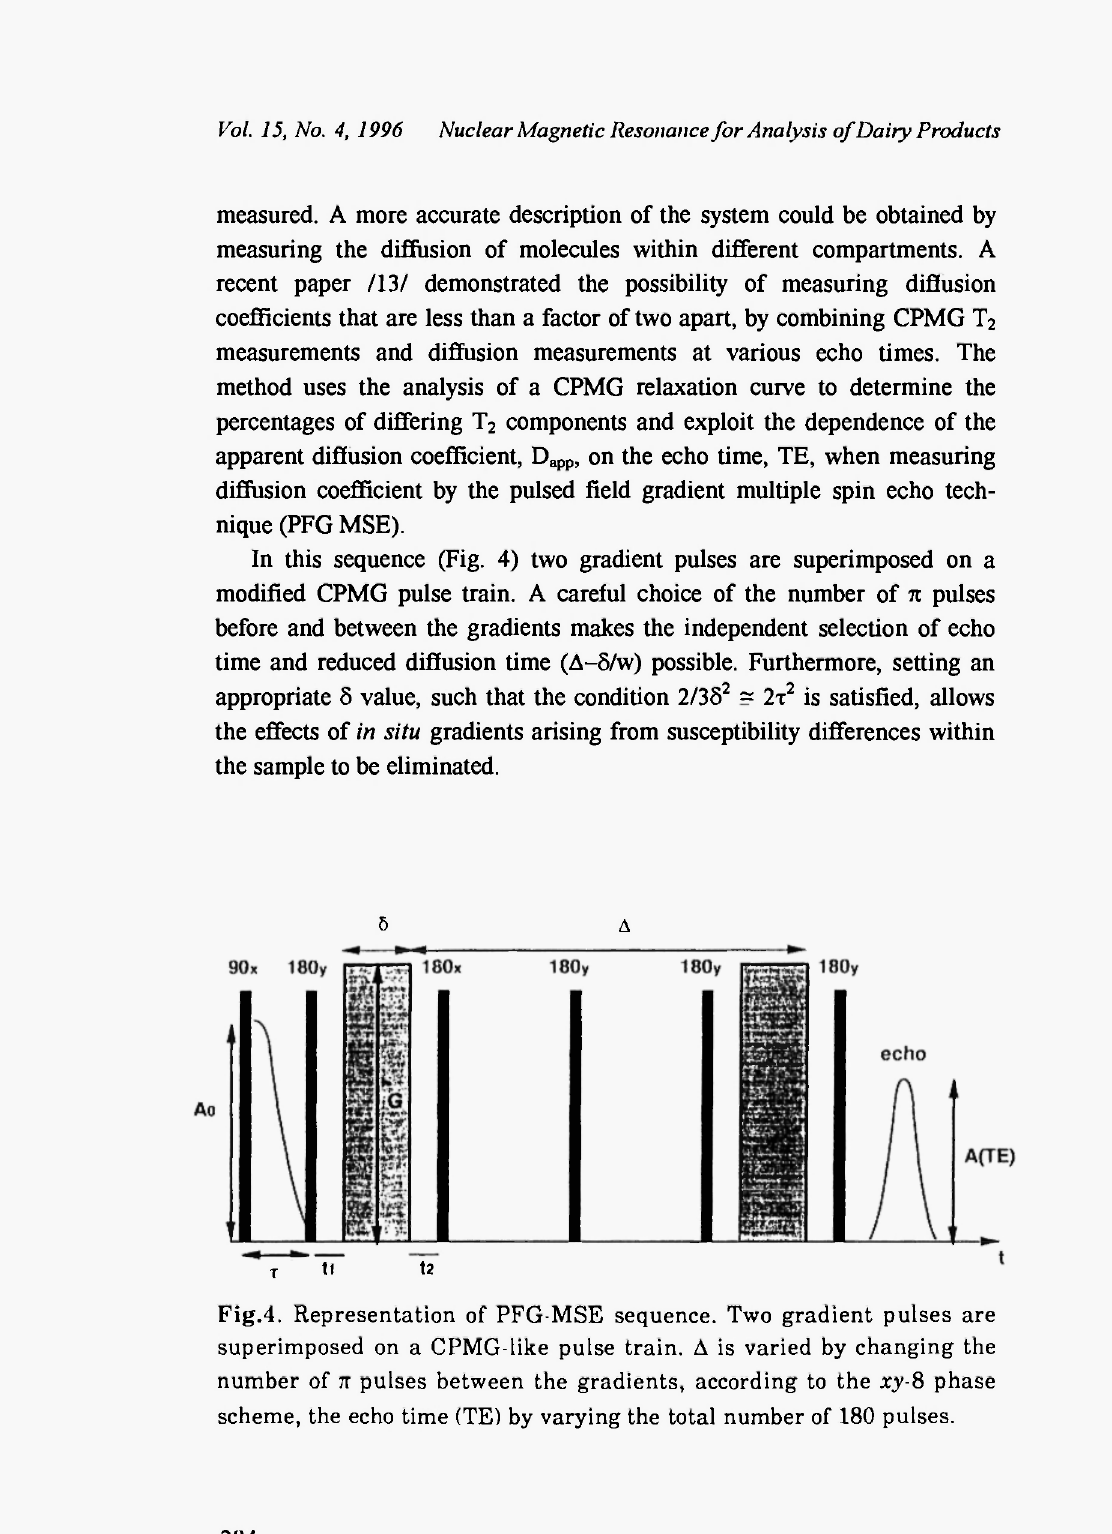
Fig.4. Representation of PFG-MSE sequence. Two gradient pulses are superimposed on a CPMG-like pulse train. Δ is varied by changing the number of π pulses between the gradients, according to the xy- 8 phase scheme, the echo time (TE) by varying the total number of 180